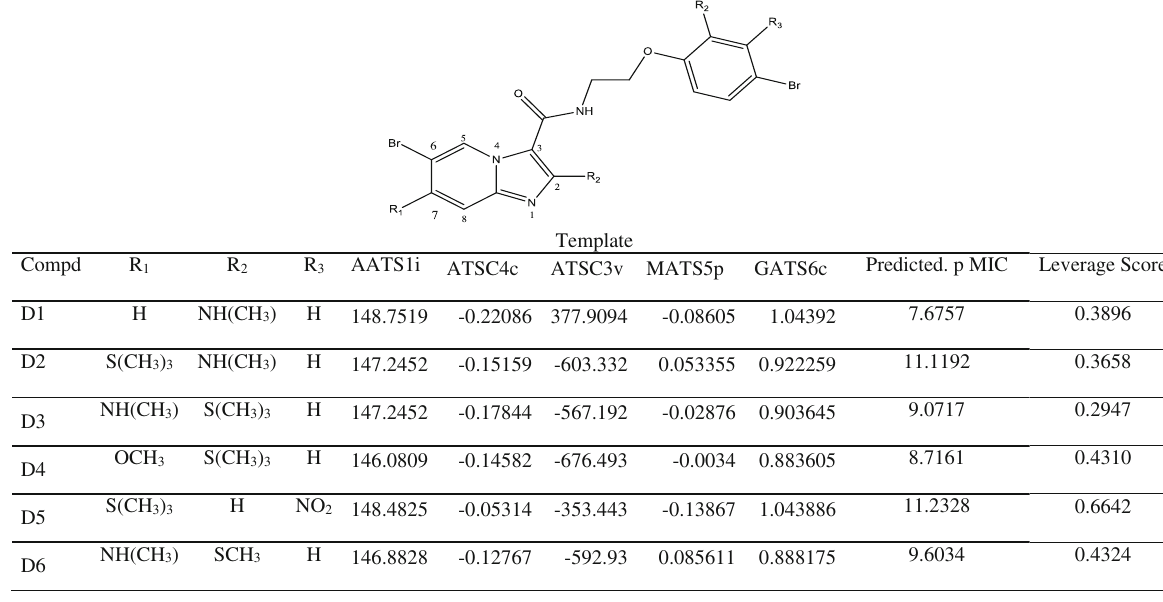
Table 9 In silico designed IPAs and their predicted anti-tubercular activities